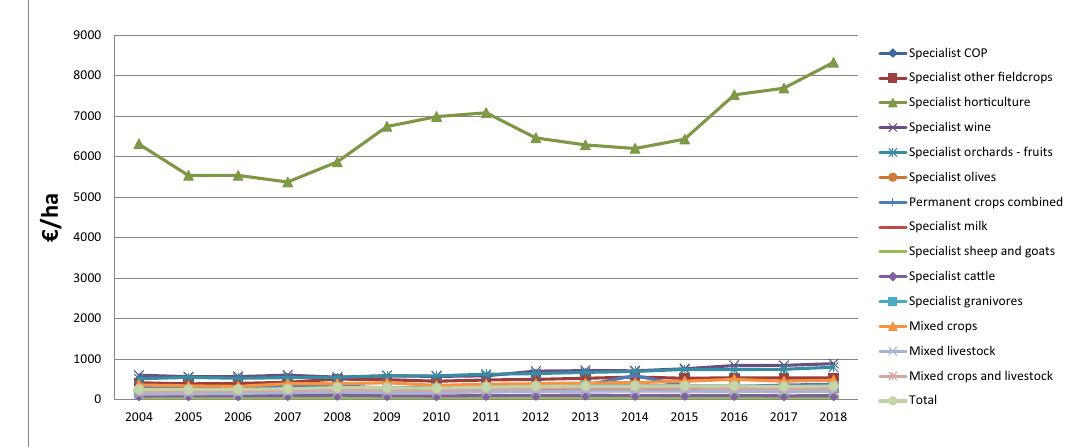
Figure 8: Speci fi c crop costs ( € /ha ) , per farm, for several farm types, for the period 2004 –